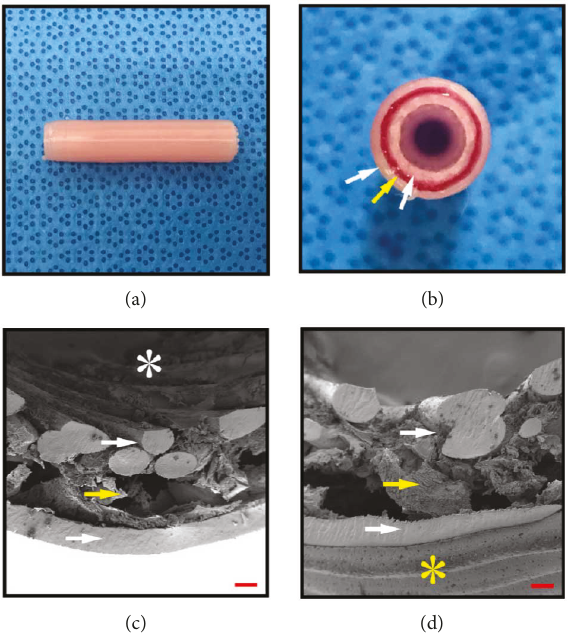
Figure 5: Gross and scanning electron microscope images of the arti fi cial vessel; (a) longitudinal view, (b) transectional view, (c) SEM image of the inner surface, and (d) SEM image of the outer surface. The white arrow indicates the polycaprolactone layer, and the yellow arrow indicates the dried sodium alginate hydrogel layer due to SEM sampling. The white asterisk indicates the inner side surface woven in a cross-striped form, and the yellow asterisk indicates the outer surface woven in a helical form. The scale bar indicates 200 μ